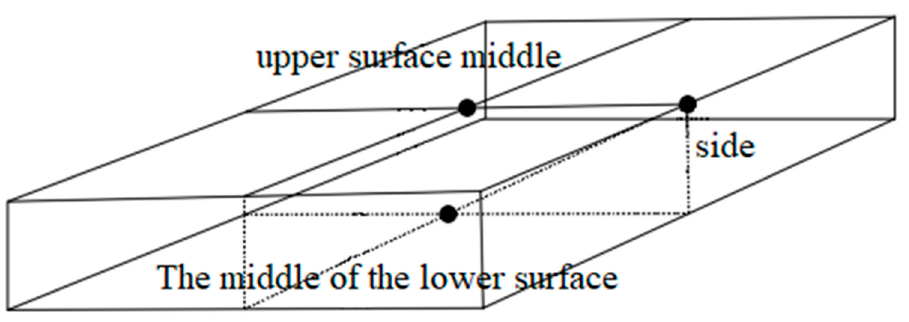
Figure 3. Layout of temperature sensor.